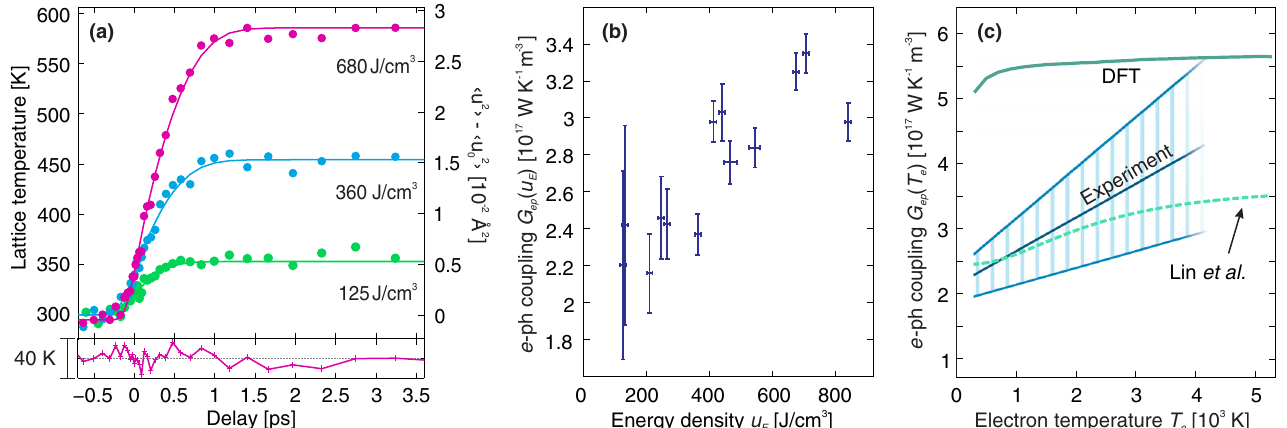
FIG. 3. (a) Measured lattice temperature (circles) and simulated lattice temperature with a TTM with optimized parameters for three different absorbed energy densities u . In the bottom, the residuals for the highest excitation density are shown. (b) Electron-phonon E coupling parameter G as a function of absorbed fluence. (c) Electron-phonon coupling dependence on electronic temperature obtained ep ð T Þ obtained from DFT calculations by evaluating Eq. (9). The dashed light green line by our measurements. The green line shows G ep e is the result from Lin et al.